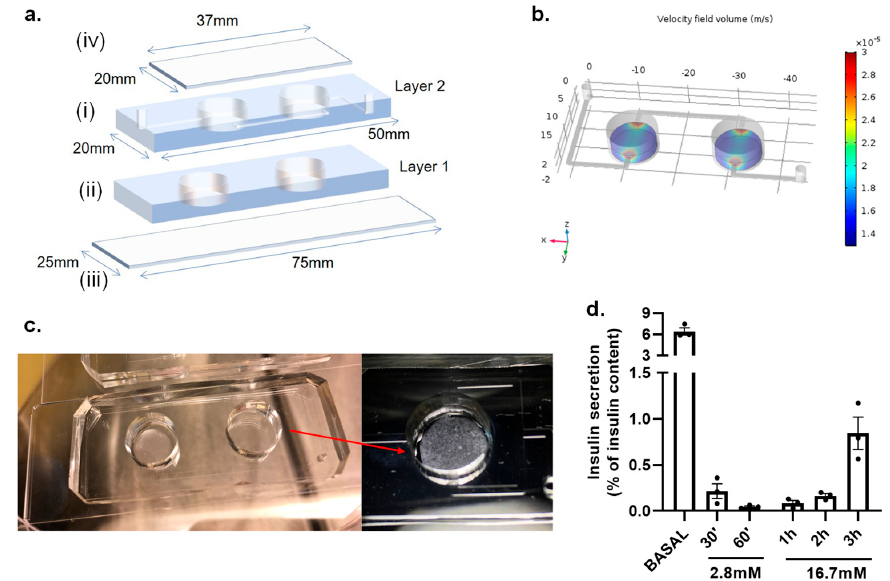
Figure 4. Design and fabrication of the IOC device. ( a ) Schematic image showing the assembling of the IOC: ( i ) a 3 mm layer of PDMS containing channels, inlet and outlet (Layer 2); ( ii ) a 2 mm layer of PDMS with the chambers for CMC islets (Layer 1); ( iii ) two-layers of microfluidic chip is bound on a (25 mm × 75 mm) standard cover slide; and, finally, ( iv ) a customized (37 mm × 20 mm) cover slide is used to sealed tissue chambers. ( b ) COMSOL Multiphysics ® simulation of the flow velocity and dynamics through the IOC device showing a maximum velocity of 0.03 mm s − 1 (red zones) at the boundaries of the scaffold. ( c ) Real picture of the IOC device with a close-up view of the CMC islets fabricated inside the chamber. ( d ) A glucose-stimulated insulin secretion (GSIS) assay was performed in static conditions to evaluate the secretory capacity of pancreatic islets housed within the CMC-based cryogel inside the device. Results are expressed as mean ± SEM from three independent